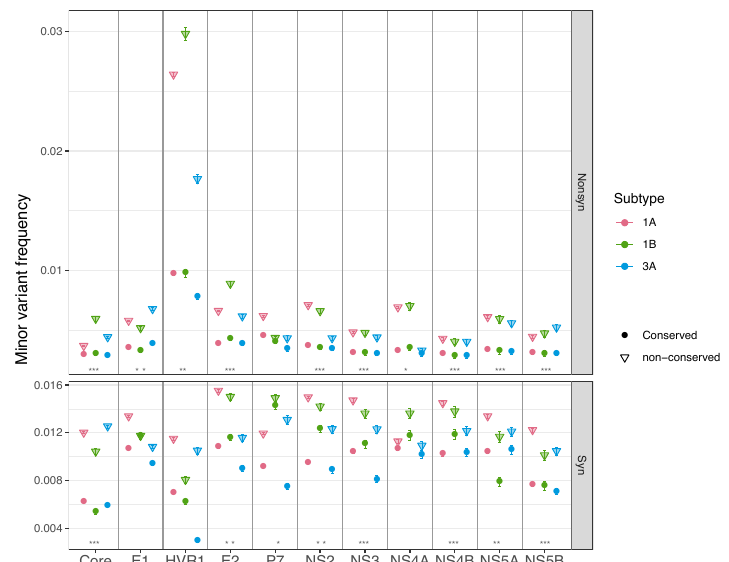
Figure 5. Comparison of average MVFs between ‘conserved sites’ and the rest of the sites (‘non- conserved sites’). The average MVFs were plotted separately for synonymous (Syn) mutations and nonsynonymous (Nonsyn) mutations. Error bars denote standard errors. Asterisks (*) denote a statistically significant difference between conserved and non-conserved sites for each subtype (from left, subtype 1a, 1b, and